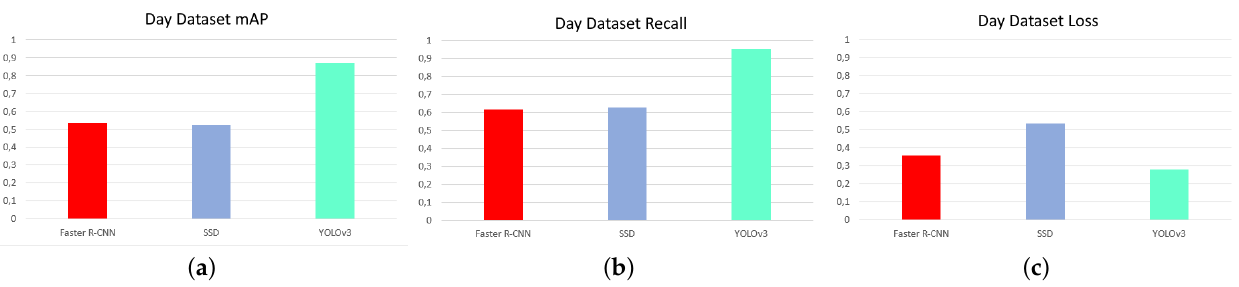
Figure 9. mAP, recall, and loss for networks with day dataset. ( a ) mAP, ( b ) recall, and ( c ) loss. Source: Authors.